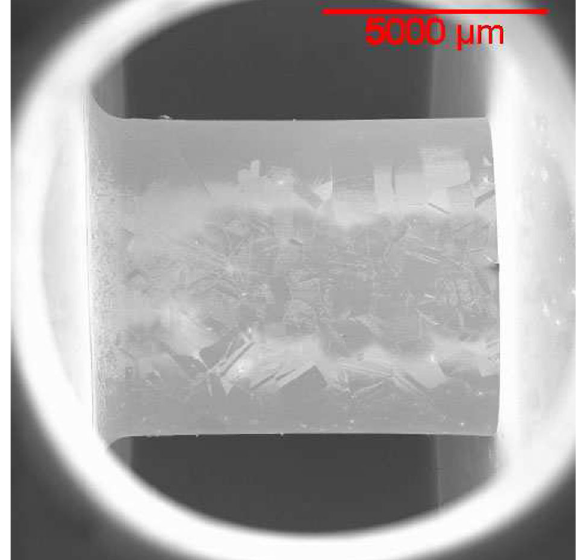
FIG. 22. SEM micrograph looking directly at high-field side of an inner rod. Grain boundaries are easily visible, and surface roughness does increase at these boundaries.